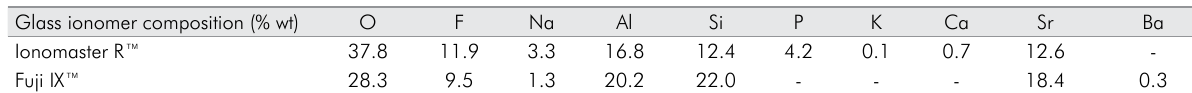
Table 3. Descriptive compositions of glass (% weight) of GICs evaluated by EDX Glass ionomer composition (%